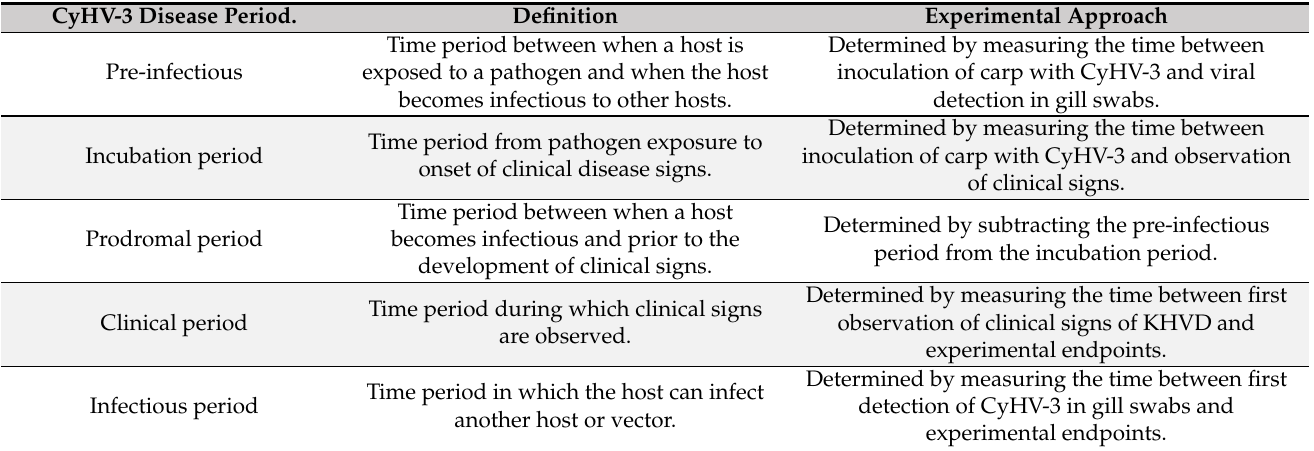
Table 1. CyHV-3 disease periods.